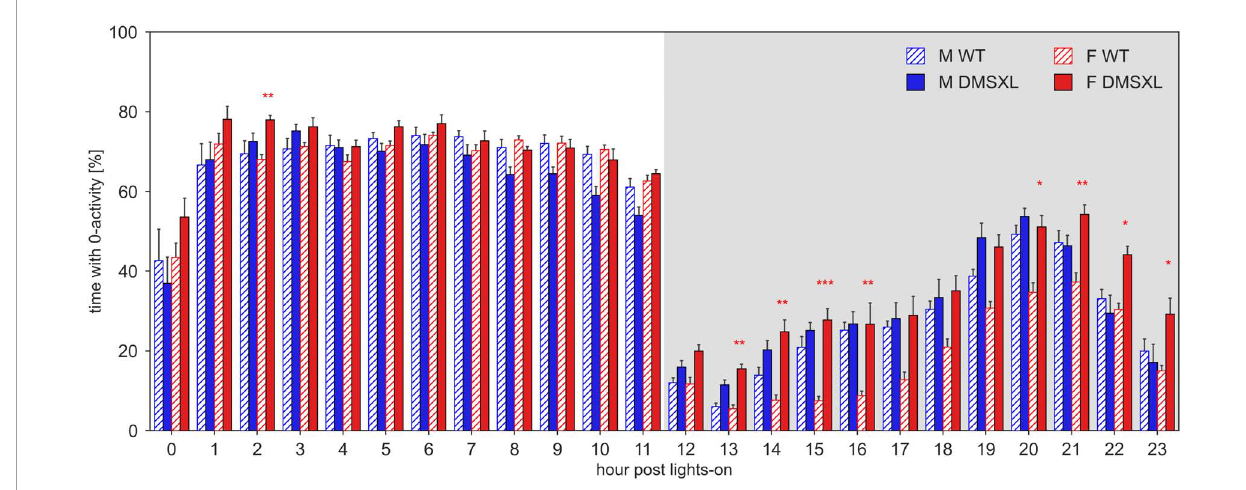
FIGURE3 Percentage of time with 0 activity across the 24 h of the day. Average percentage of time ( ± SEM) per hour post lights-on, across the 5 weeks of experiment in male (M, blue) and female (F, red) cages of wild-type (WT) (diagonal lines), and DMSXL (filled bar) mice. N of cages per group: M